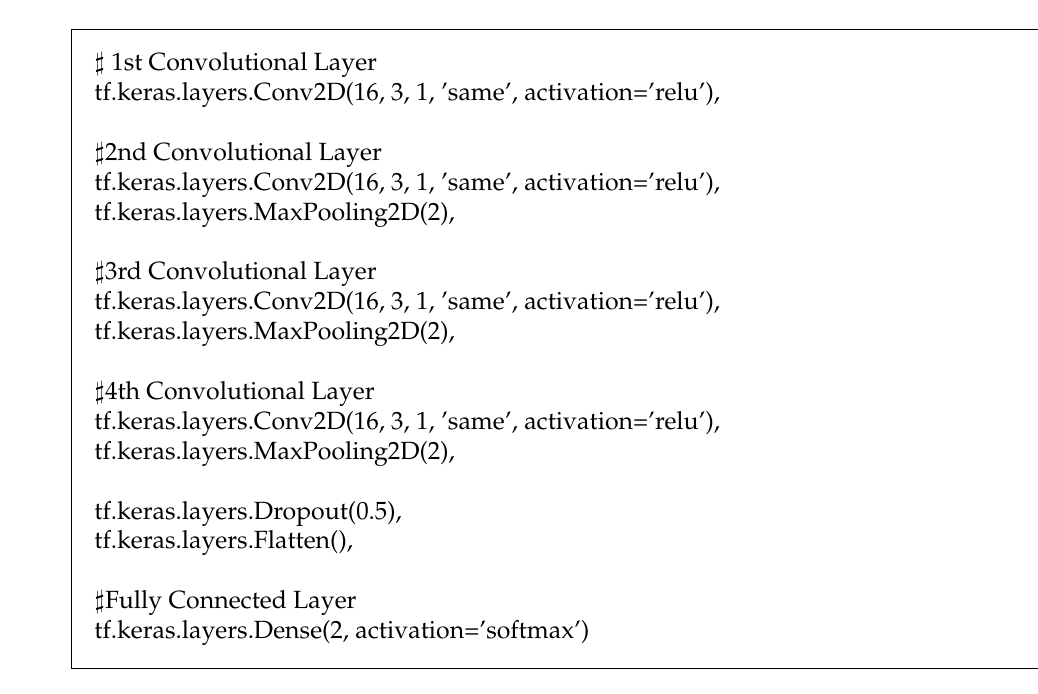
Figure 4. The CNN model used in the experiment.